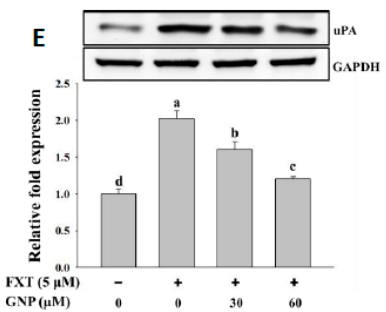
Figure 5. Western blot analysis of MMP-2 ( A ), MMP-9 ( B ), TIMP-1 ( C ), TIMP-2 ( D ) and uPA ( E ) proteins expression in HepG2 cells after treated with FXT and the attenuating effect of GNP. HepG2 cells were seeded onto a 6-well plate and incubated overnight, treated with FXT and GNP at dose as indicated and further incubated for 72 h. DMSO (0.1%) was used as vehicle control. Values are expressed as mean ± SD ( n = 3). Different letters indicate statistical significance ( p < 0.05).